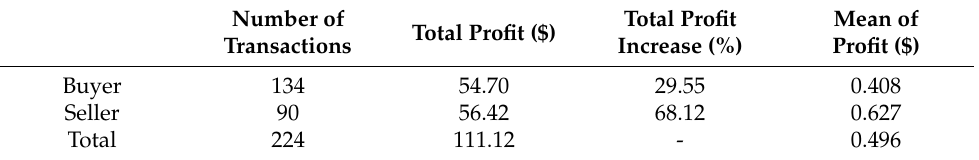
Table 4. Result of the smart match.